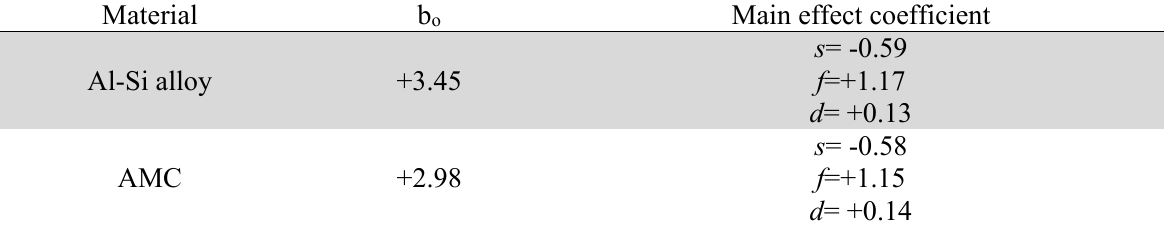
Regression equation coefficients for the alloy and composite (surface roughness) Material